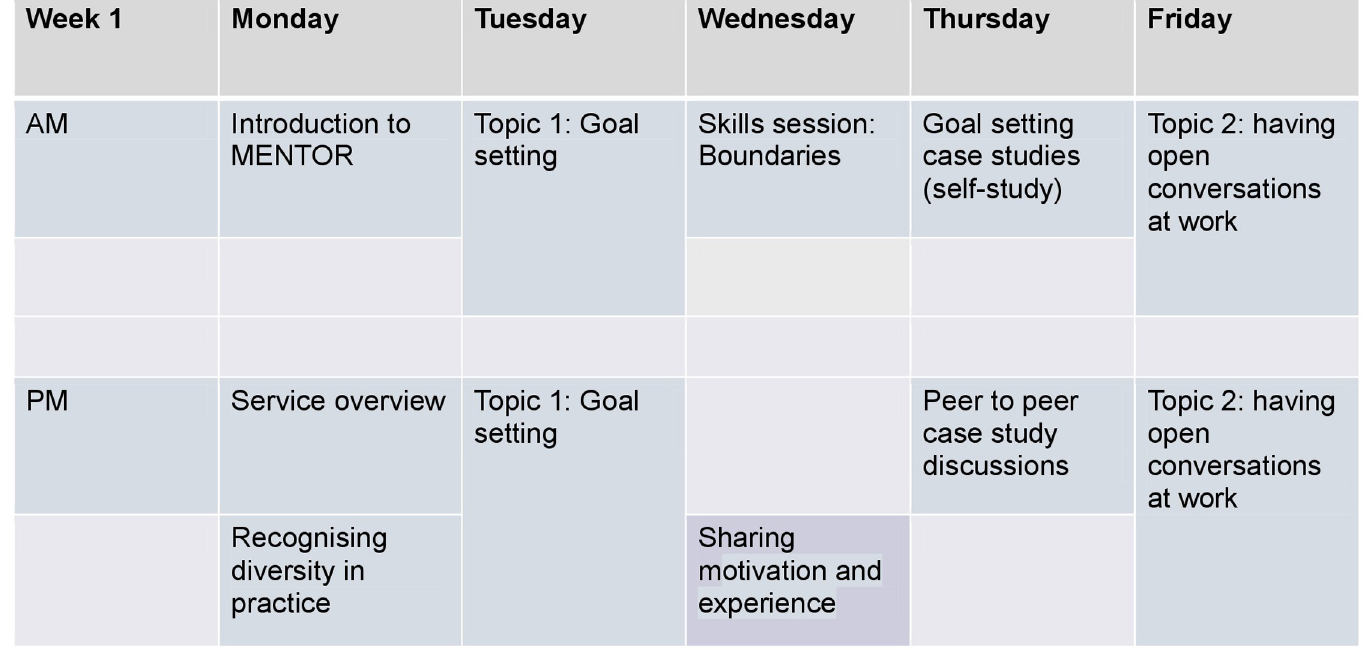
Fig 5. MENTOR training